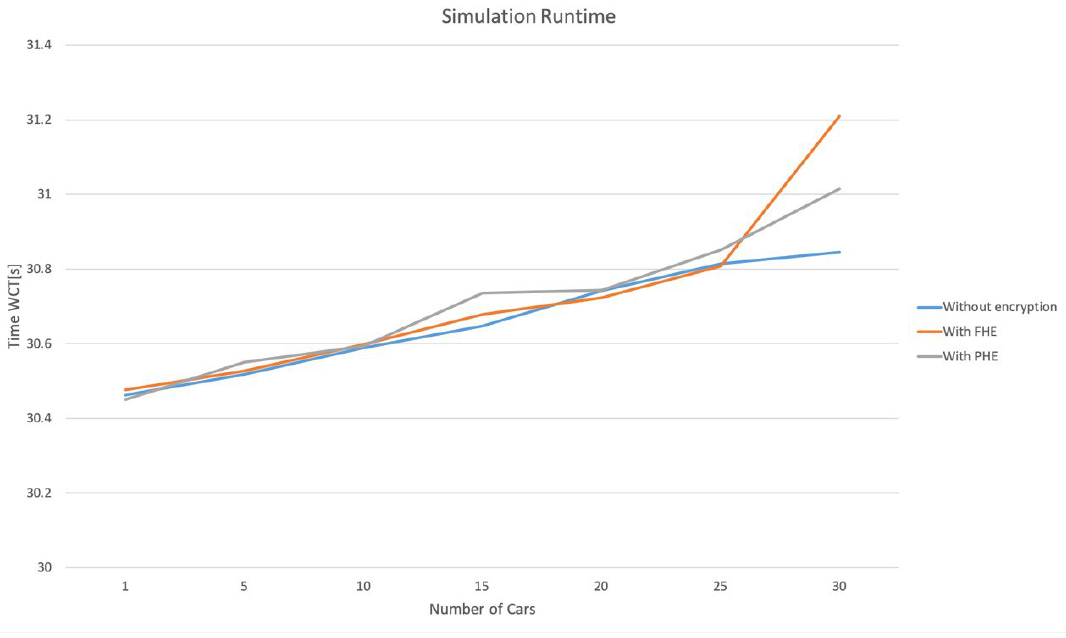
Figure 10. Runtime of the simulation with and without (fully, partial) homomorphic